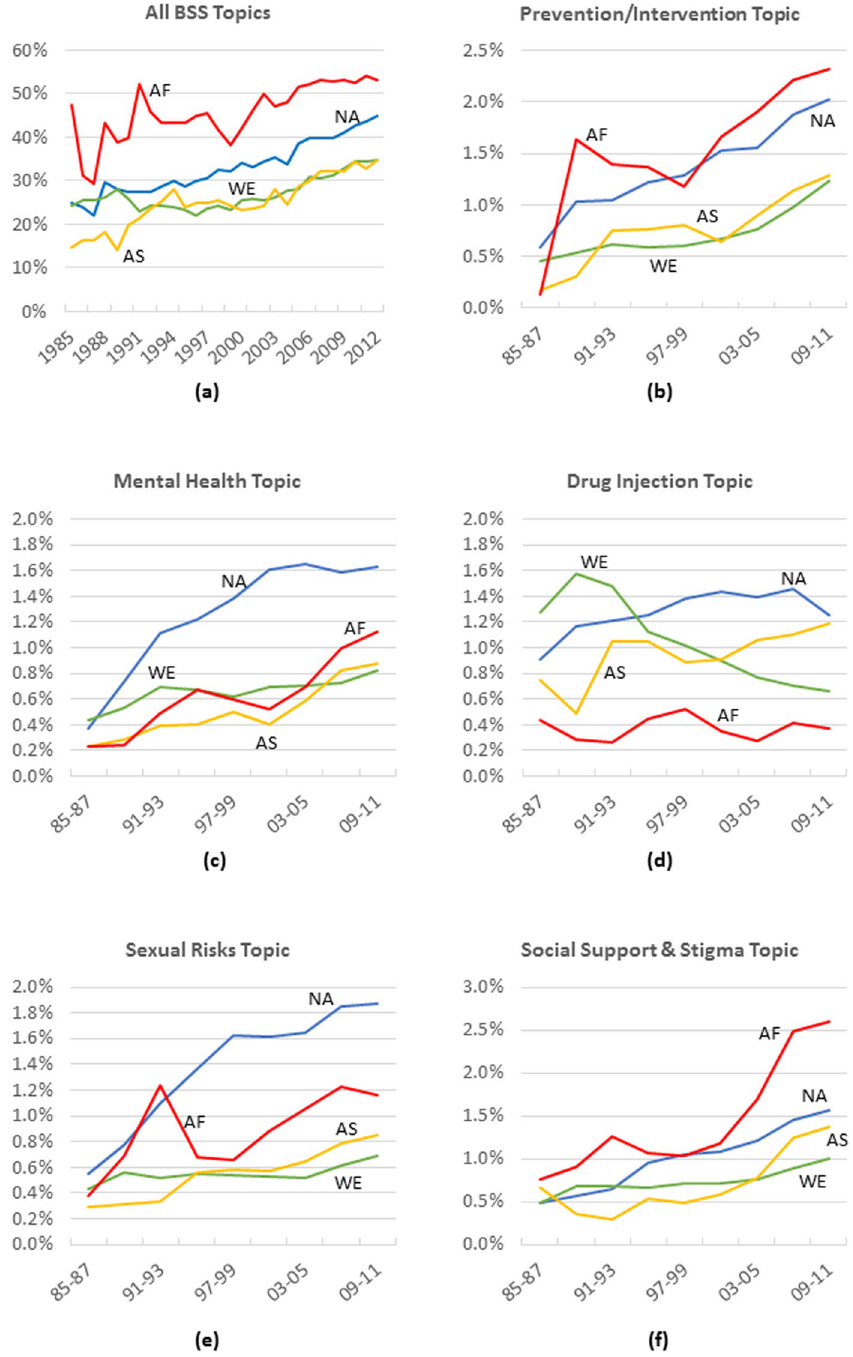
Figure 4. Regional variation in trends of BSS topics in the context of HIV/AIDS research. NA: North America, WE: Western Europe, AS: South and Southeast Asia, AF: Sub-Saharan